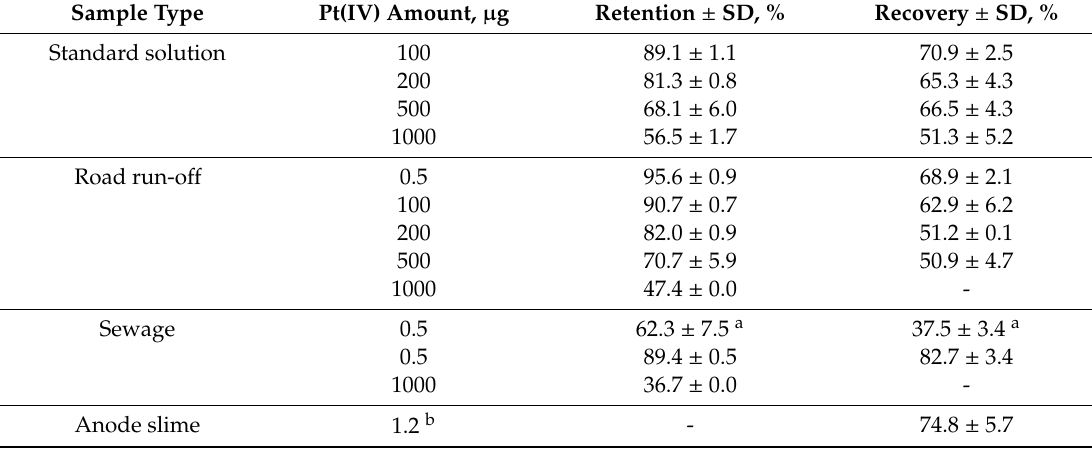
Table 3. Application of fungi Aspergillus sp. for separation of Pt(IV) from various samples (sample pH 2, mass of biosorbent 0.1 g, contact time 2 h, washing agent: 0.01 mol L − 1 HNO 3 , n =